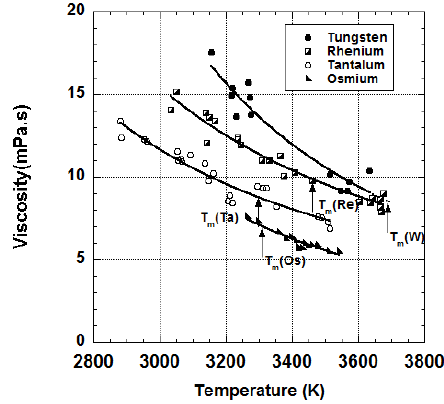
Figure 15. Measured viscosity of molten refractory metals versus temperature.